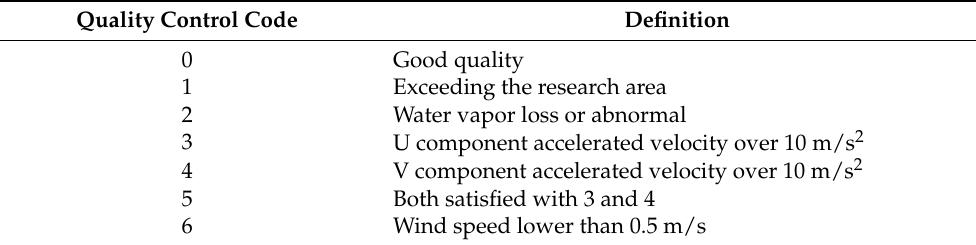
Table 3. The quality control